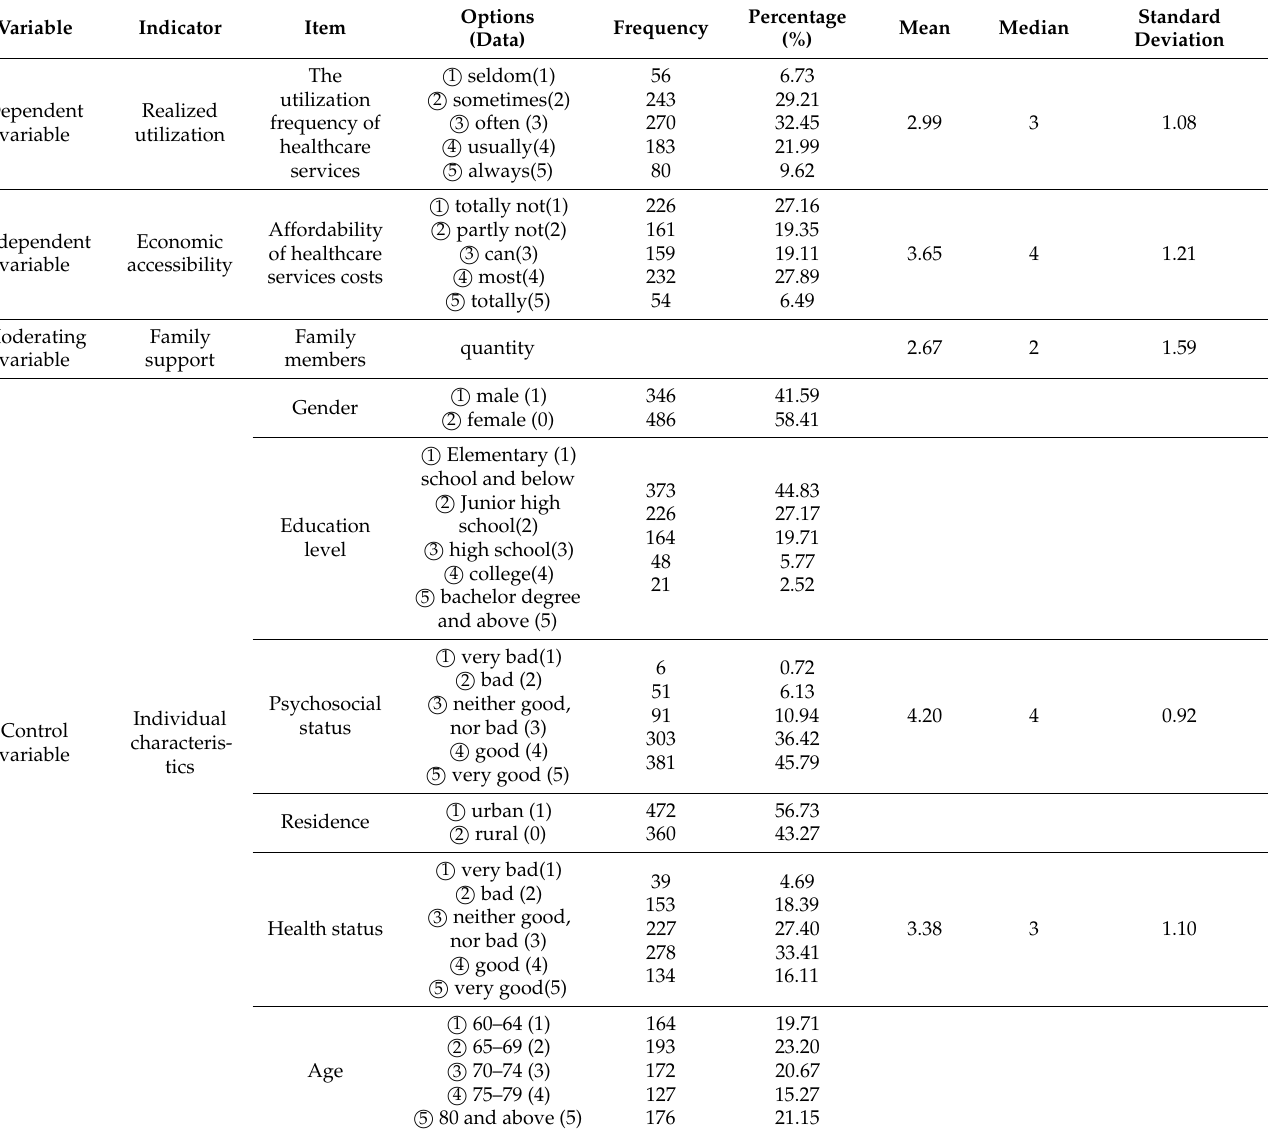
Table 1. Variables, indicators and sample